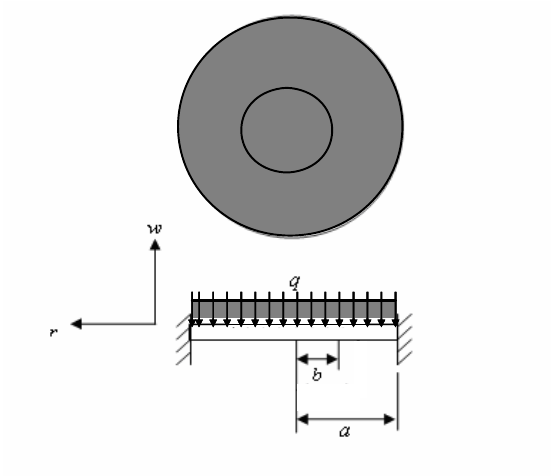
Figure 2. Fixed-edge circular diaphragm with a uniform load distributed over a central circular area with radius 0 < r < a